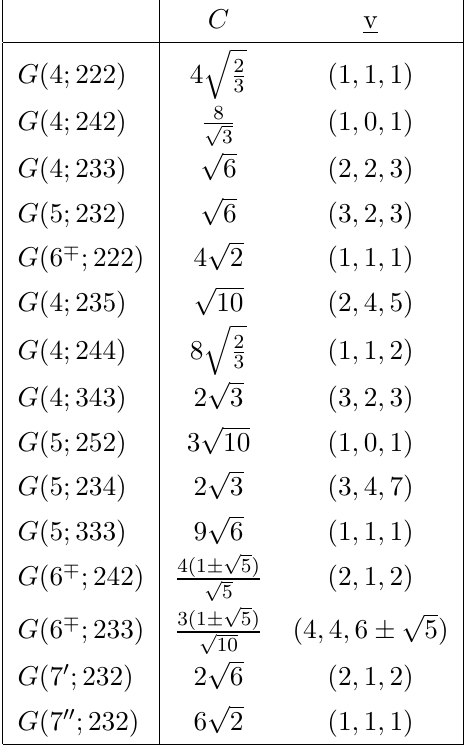
Table 2 . Tree-level four-point functions of single-trace operators, computed by Wick contraction are encoded in a prefactor C and a vector v ; namely G ( (cid:1) (cid:1) (cid:1) ) = C v (cid:1) a where the position vector is a = ( a 2 ; a 23 a 34 ; a 2 23 34